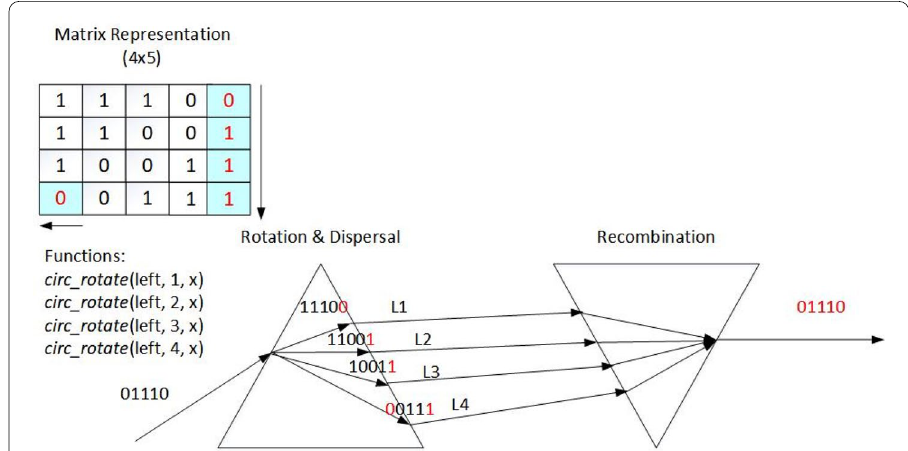
Fig. 7 Passing the classical bit string 01110 through the bit prism